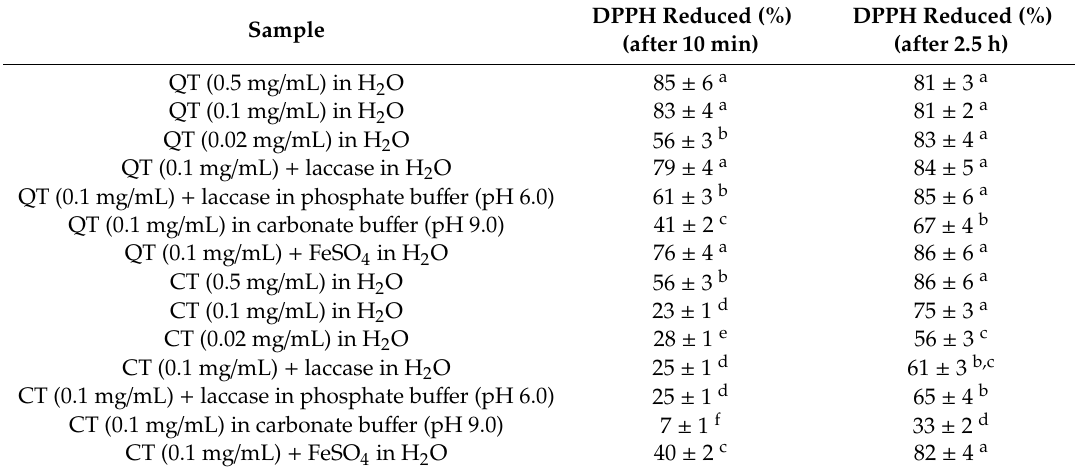
Table 1. 2,2-Diphenyl-1-picrylhydrazyl (DPPH) reduction at di ff erent times by the tannin-coated nylon membrane filters.